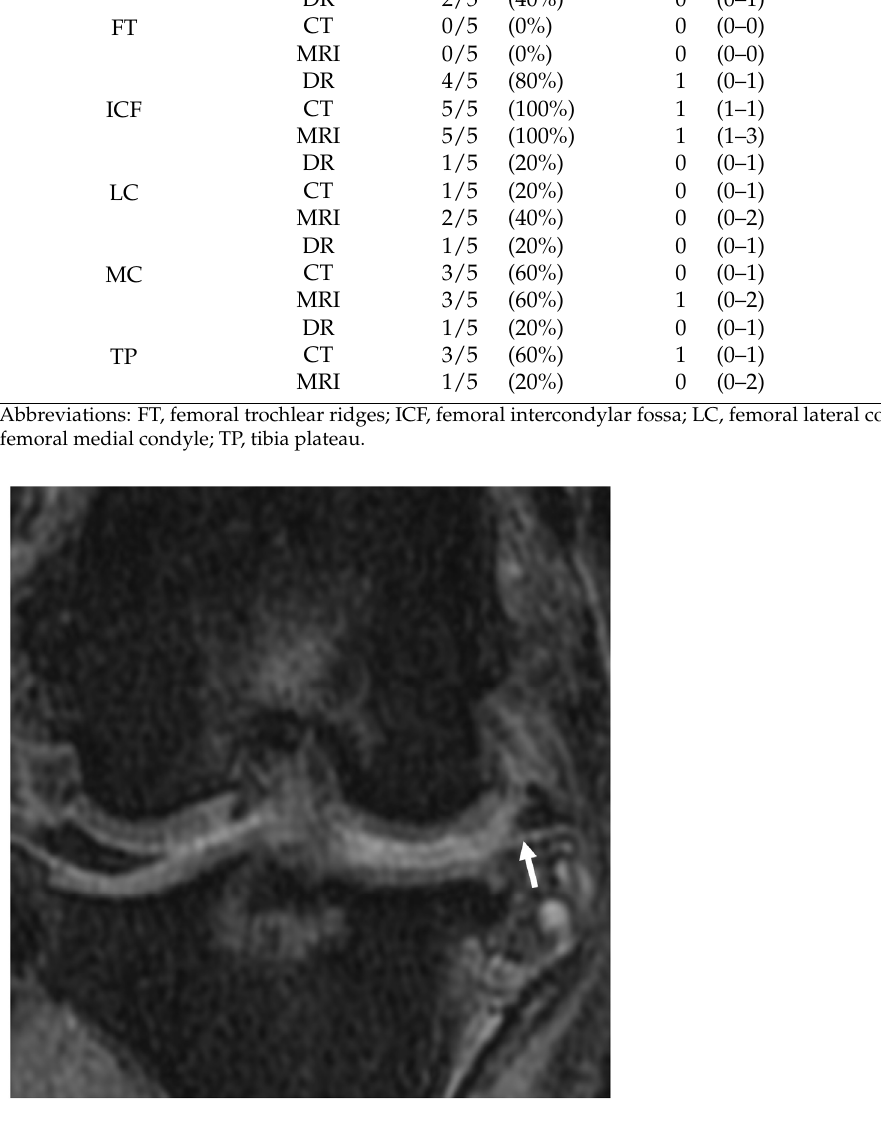
Figure 10. Meniscal maceration lesion noted on the dorsal plane, PDW fs MRI image. Chronic degenerative meniscal changes resulting the separation of the meniscus into constituent fragments (arrow). Synovial effusion accumulation is noted between the femoral condyle and tibial plateau, where the meniscus normally exists. Table 5. Results of cartilage MRI T2 relaxation time.